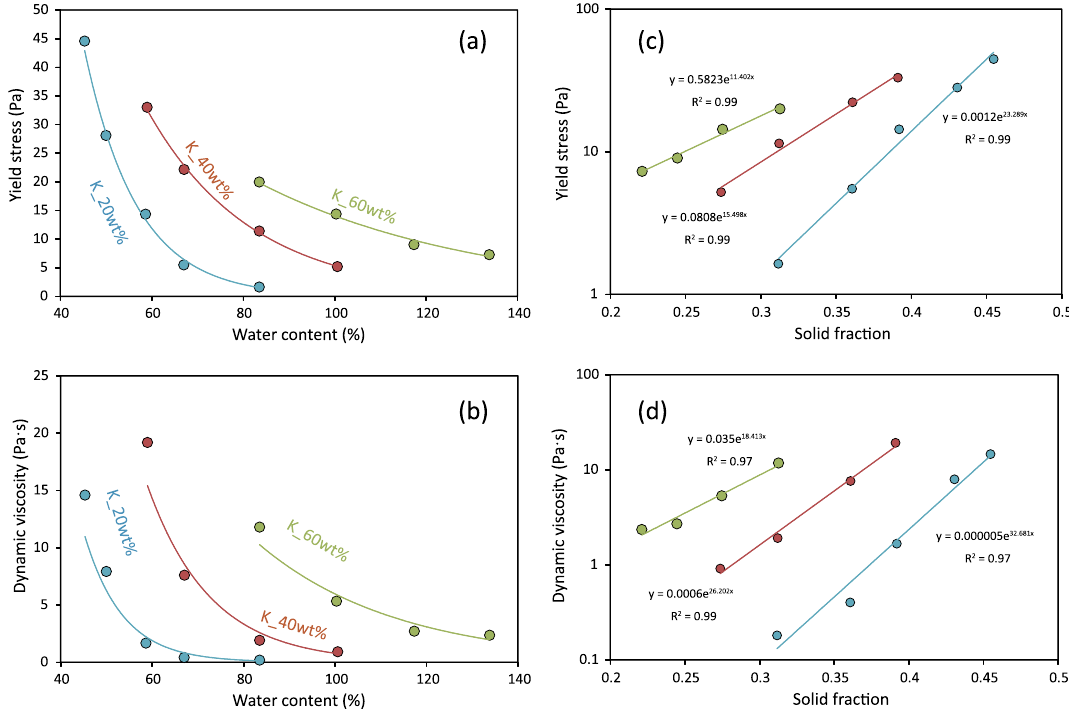
Figure 2. Plots of ( a , b ) rheological parameters versus water content, and ( c ) yield stress and ( d ) dynamic viscosity versus the solid fraction Φ of the suspension. Different kaolinite–quartz ratios are indicated by colored symbols.